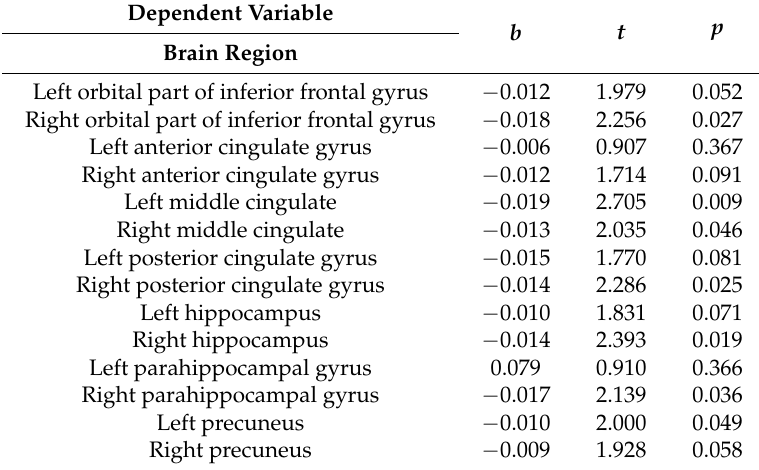
Table 2. Structural changes relying on insulin resistance exposure in Alzheimer’s